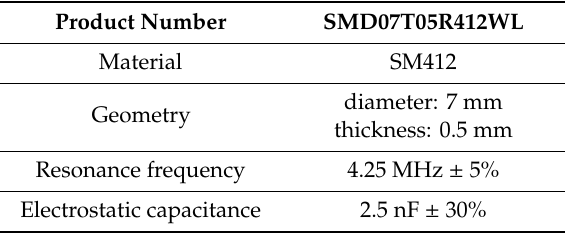
Table 3. Material properties of aluminum for experiment.